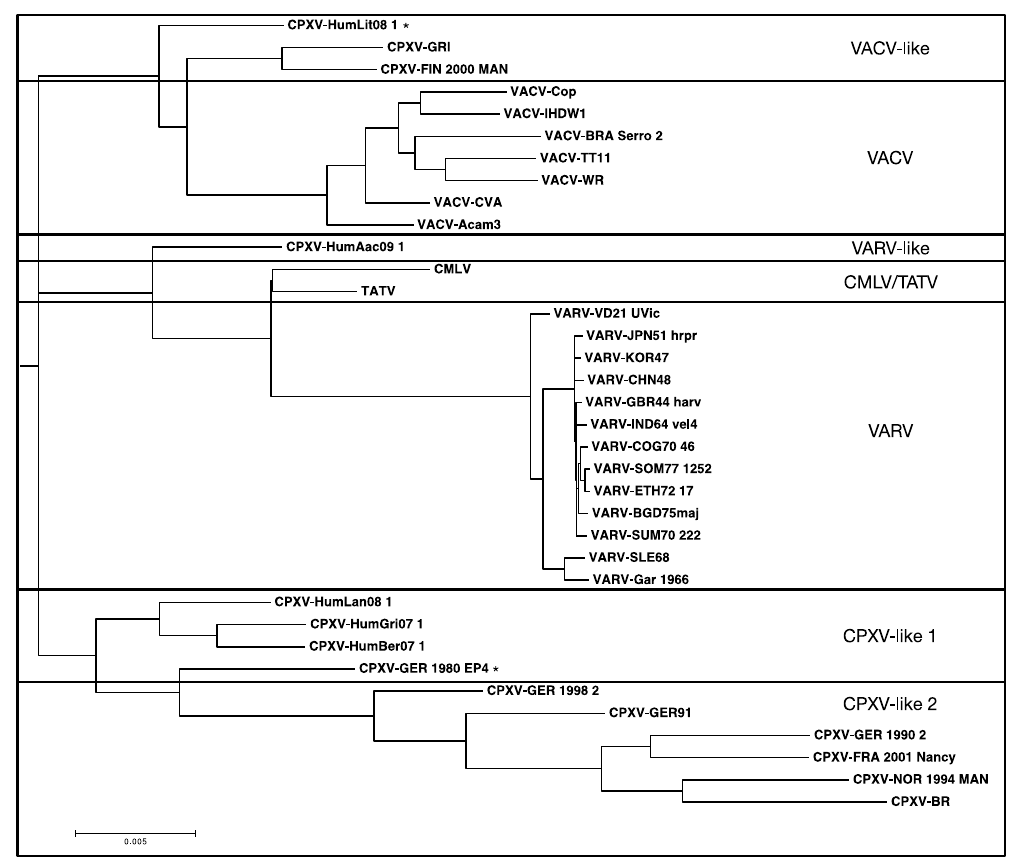
Figure 8. RAxML rooted phylogenetic tree. Species are delineated by bold lines; asterisks indicate isolates that do not fall into clear strain categories [9]. The tree was created from the MAFFT aligned orthopox core region (with gaps and Ns removed) using RAxML under a GTRGAMMA base substitution model using 1000 bootstrap replicates and visualized using MEGA7 (Molecular Evolutionary Genetics Analysis) software.